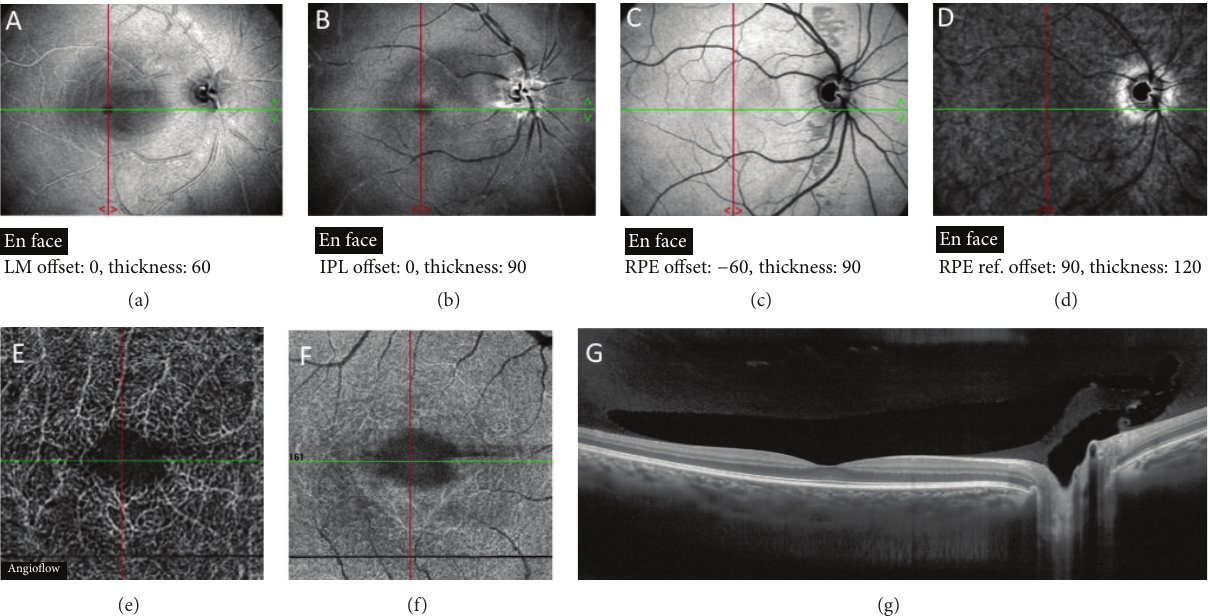
Figure 1: OCT images of normal eye. (a)–(d) En face OCT images at different segmentation thicknesses. (e)-(f) Angio-OCT images of, respectively, superficial and deep retinal plexus. (g) Premacular bursa appears on OCT as boat-shaped lacunae in the macular